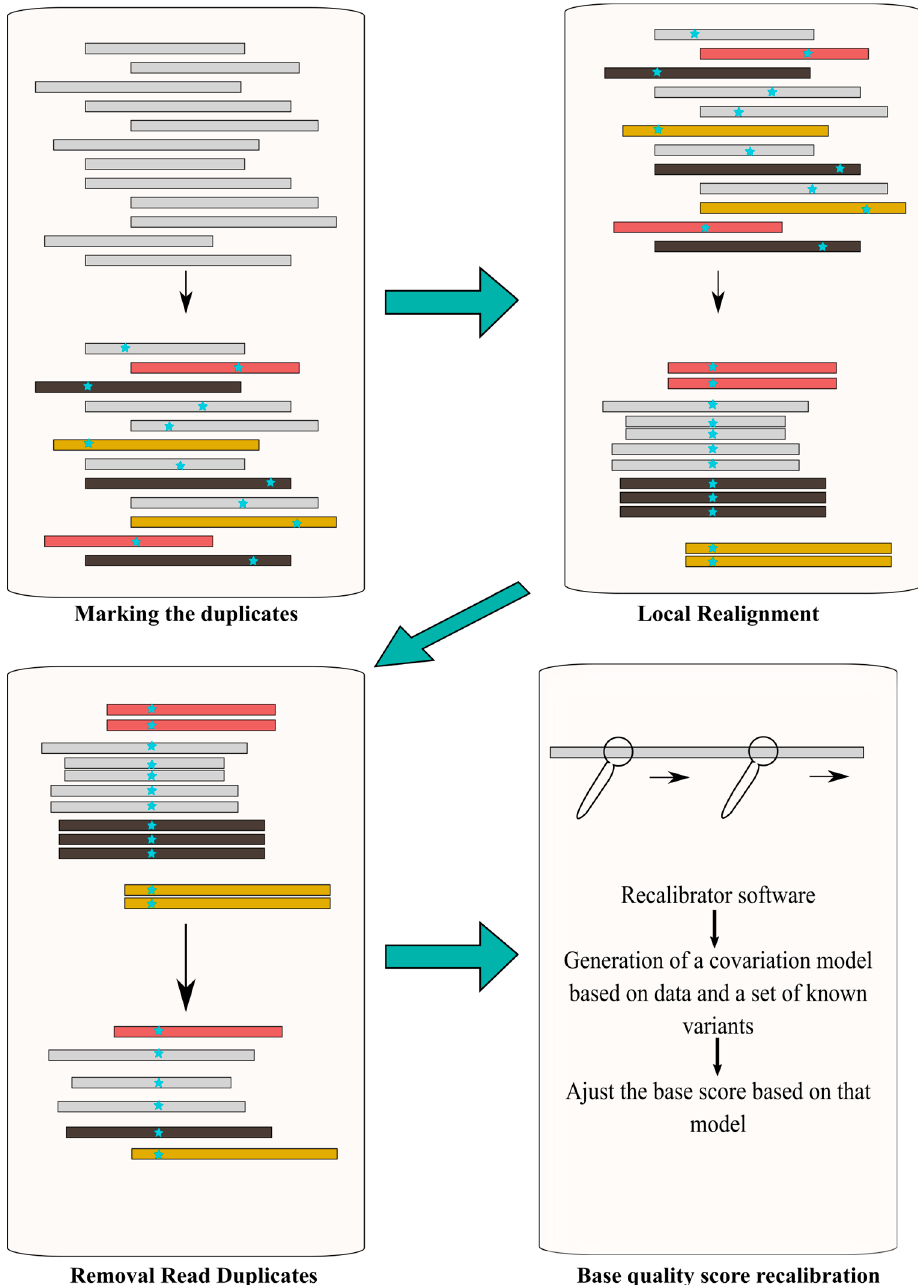
Figure 5. Schematic representation of the main steps involved in the post-alignment process.